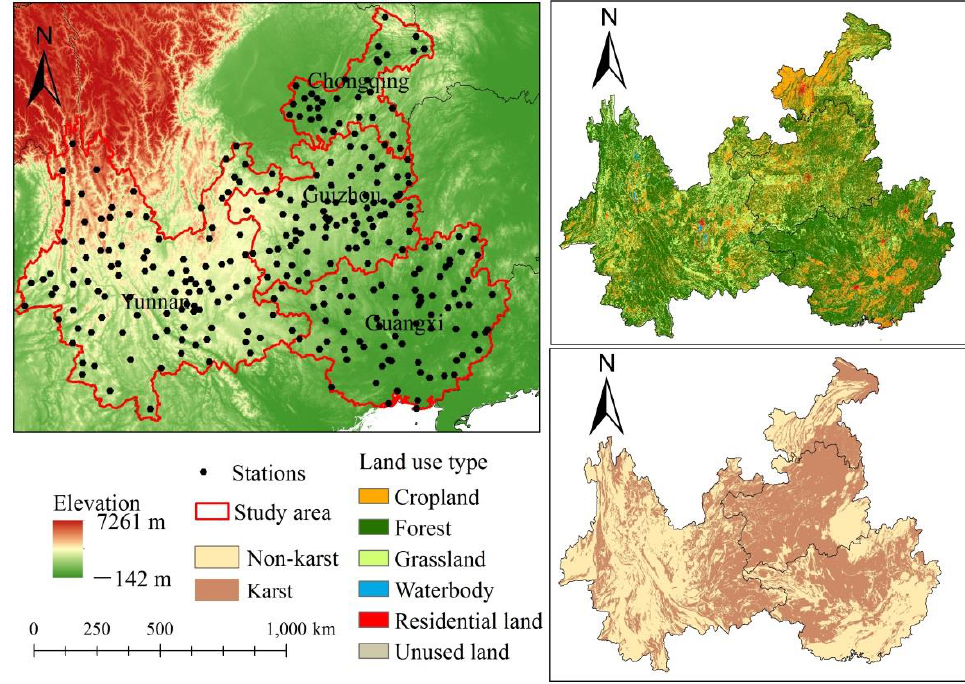
Figure 1. The distribution of the karst area and land use types in the study region.